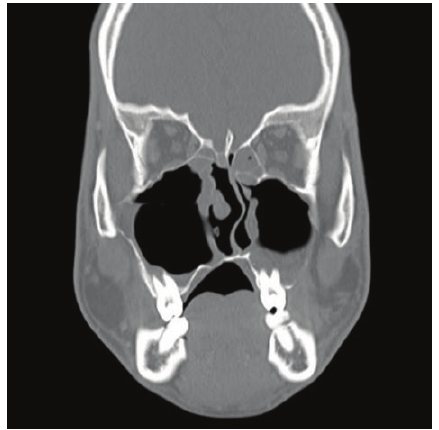
Figure 4: A postoperative coronal computed tomography scan shows that the right maxillary cyst has been removed and obstruc- tion of the inferior nasal meatus has resolved